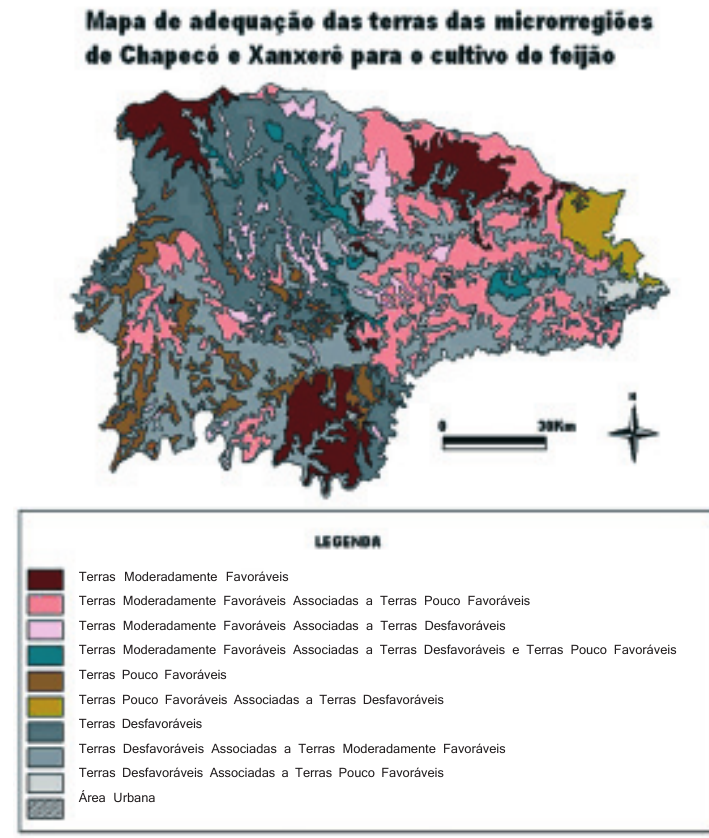
Figura 7. Classes de adequação das terras para o cultivo do feijão.